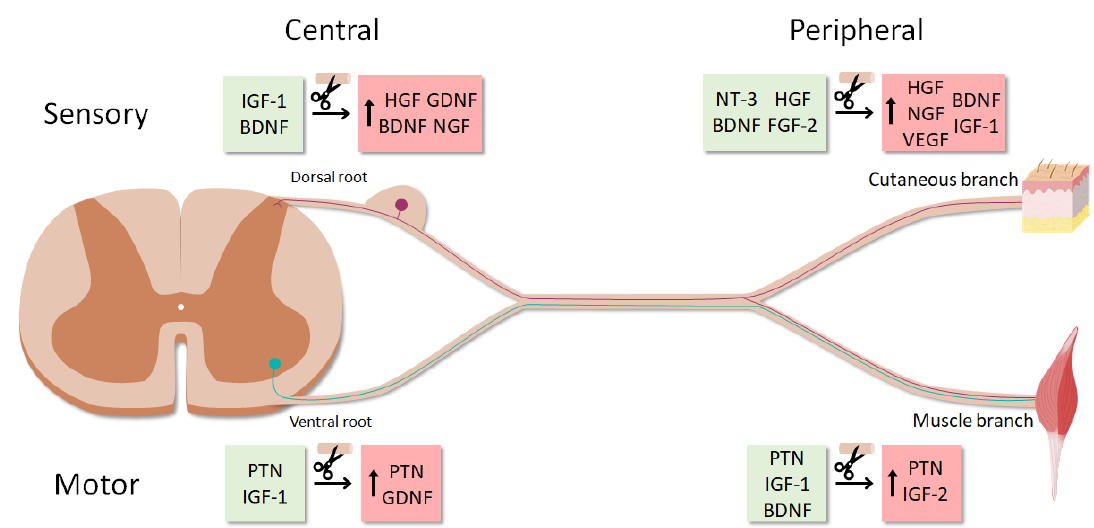
Figure 3. Growth factors are differentially expressed by SCs, depending on their modality and their location in the central-peripheral axis. After denervation, the regulation of neurotrophic factor expression also varies between SC subtypes. For instance, GDNF is mainly upregulated in dorsal and ventral roots, whereas PTN is highly upregulated in denervated motor SCs, both central and peripheral. Denervated sensory SCs in the peripheral nerve strongly upregulate several factors, among which HGF, BDNF and NGF are the most distinctive.